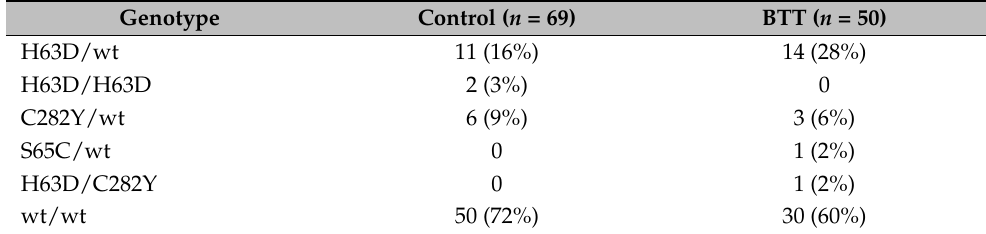
Table 1. Mutations in the HFE gene in β -thalassemia trait and apparently healthy